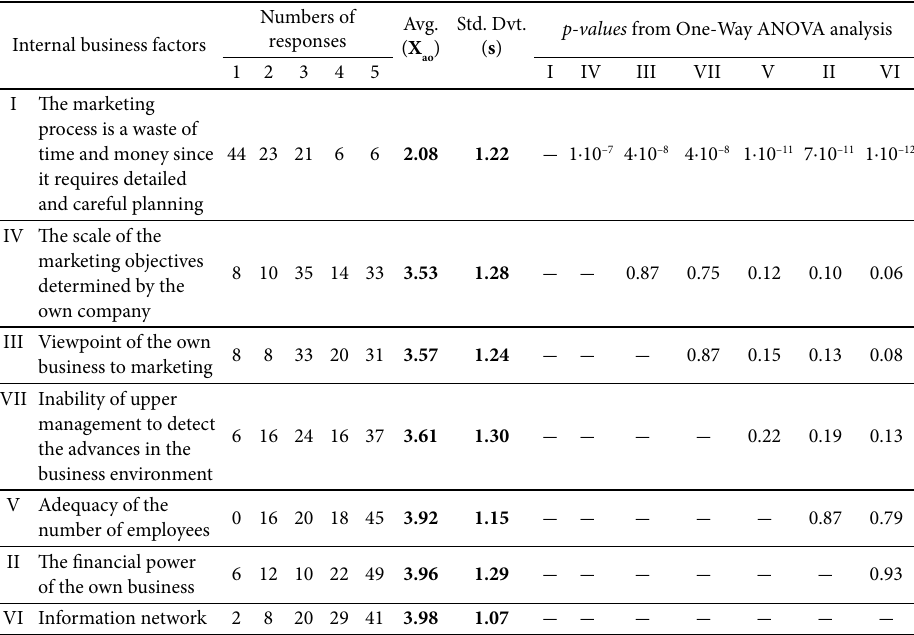
Table 1. Numbers of Responses and p-values from One-Way ANOVA Analysis about the Internal Business Factors That Affect the Marketing